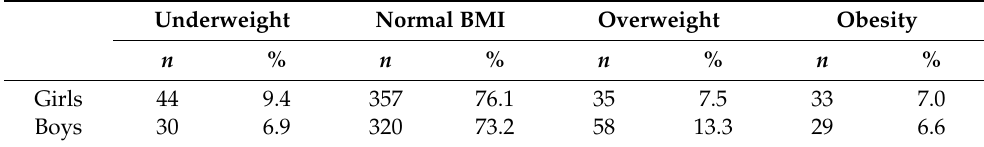
Table 1. Distribution of the nutrition status of children surveyed according to